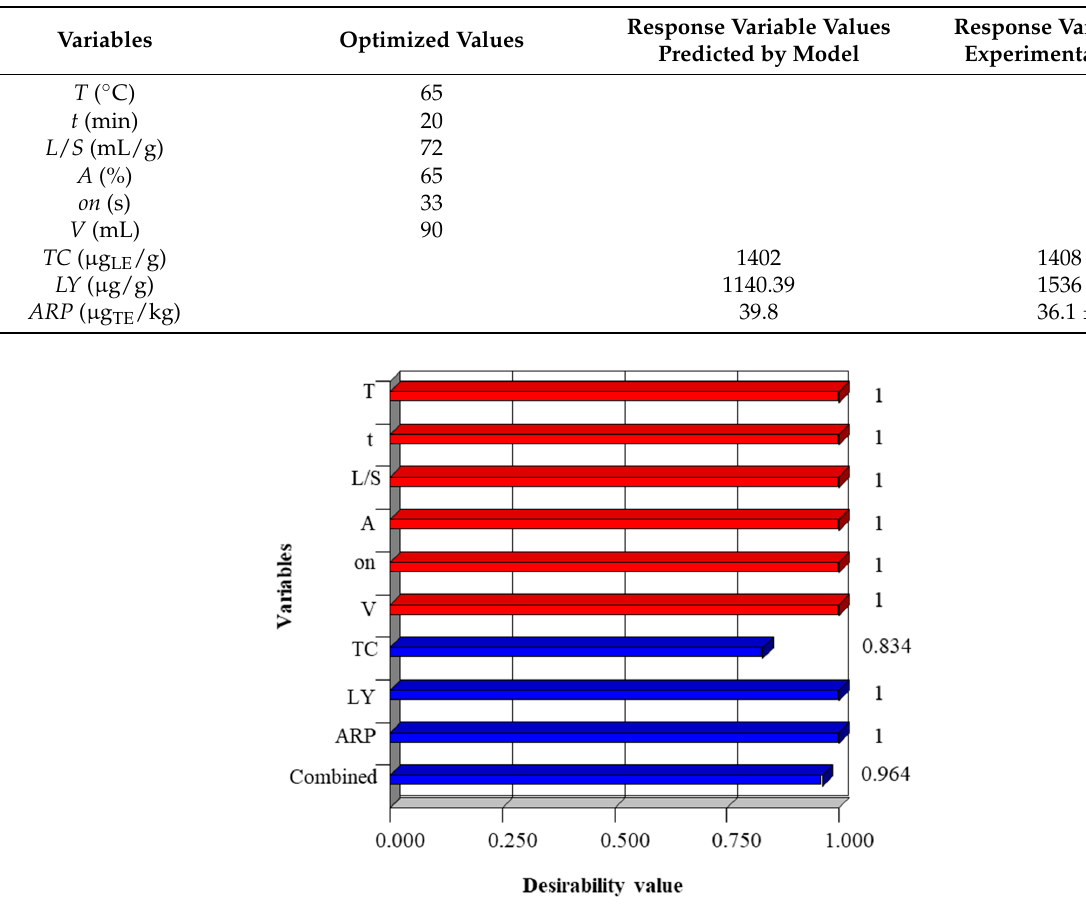
Figure 4. Desirability values for the input and response variables.